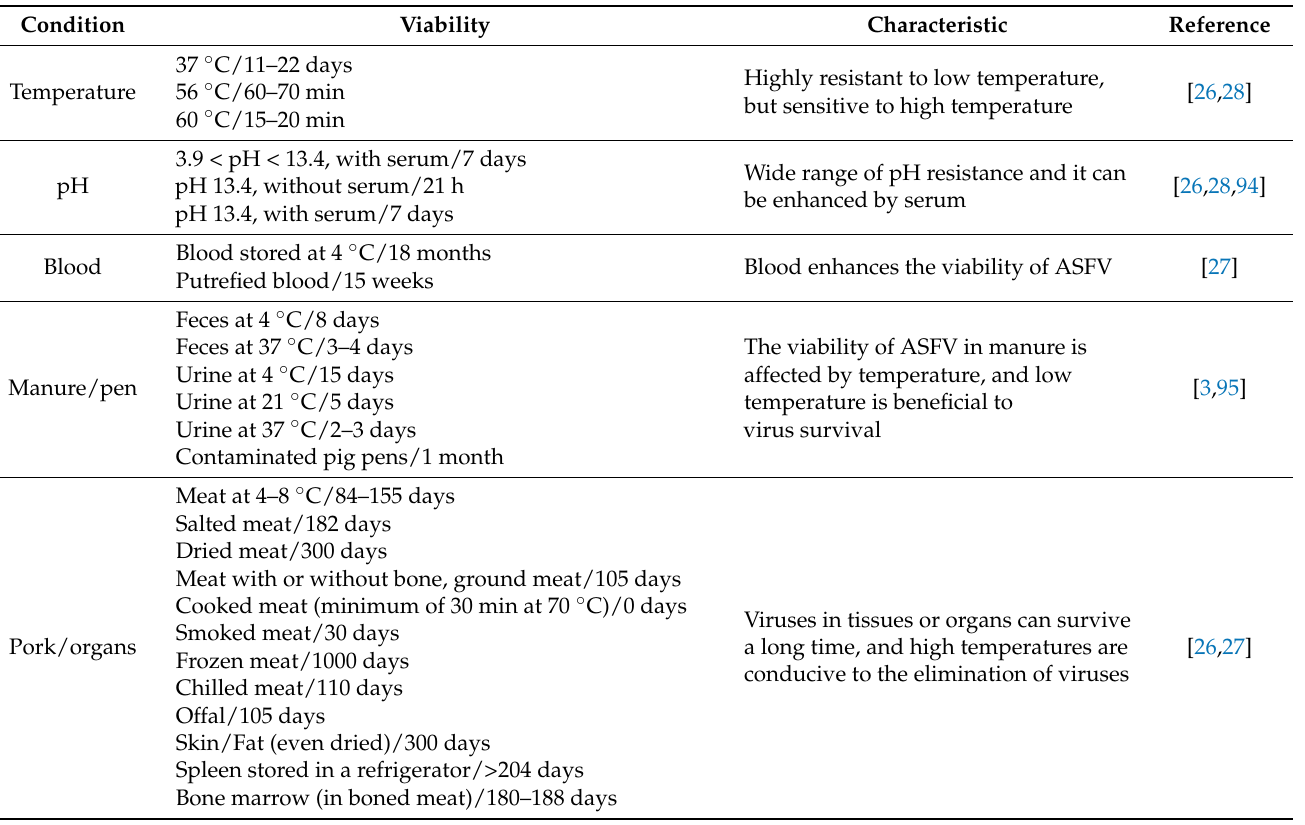
Table 2. The viability of ASFV under different